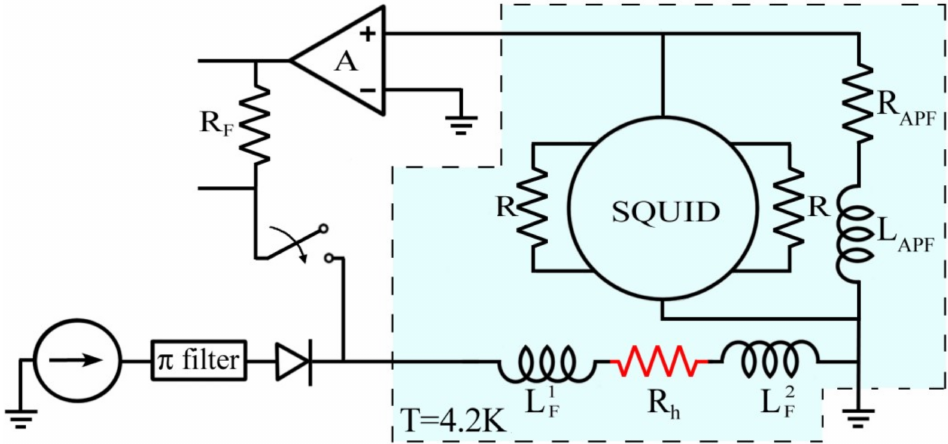
Figure 2. Readout electronic scheme for the SQUID magnetometer characterization. The device is directly coupled to a low noise voltage amplifier. A flux locked loop circuit is used to increase the linear dynamic range. A battery powered current generator sends a current into the integrated heater in order to modify the critical current of the